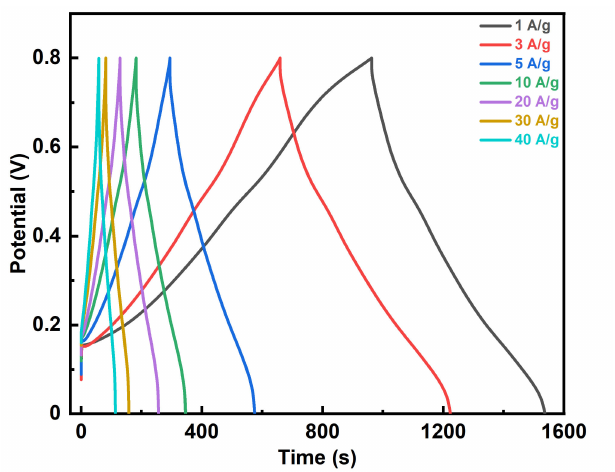
Figure 8. Galvanostatic charge–discharge curves of a symmetric FTO-PANI supercapacitor at 1, 3, 5, 10, 20, 30, and 40 Ag − 1 in a three electrode